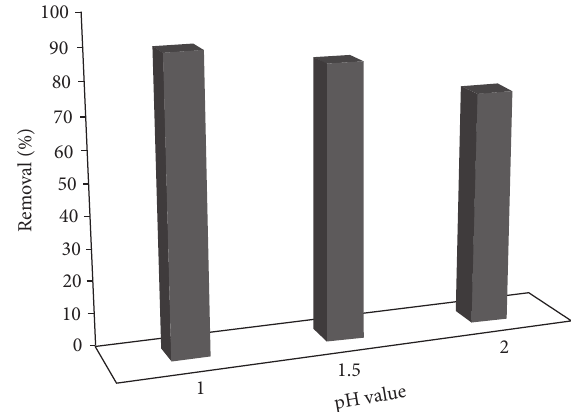
Figure 11: Effect of pH on the regeneration of PGMA-MAn/ ABSAc@Fe 3 O 4